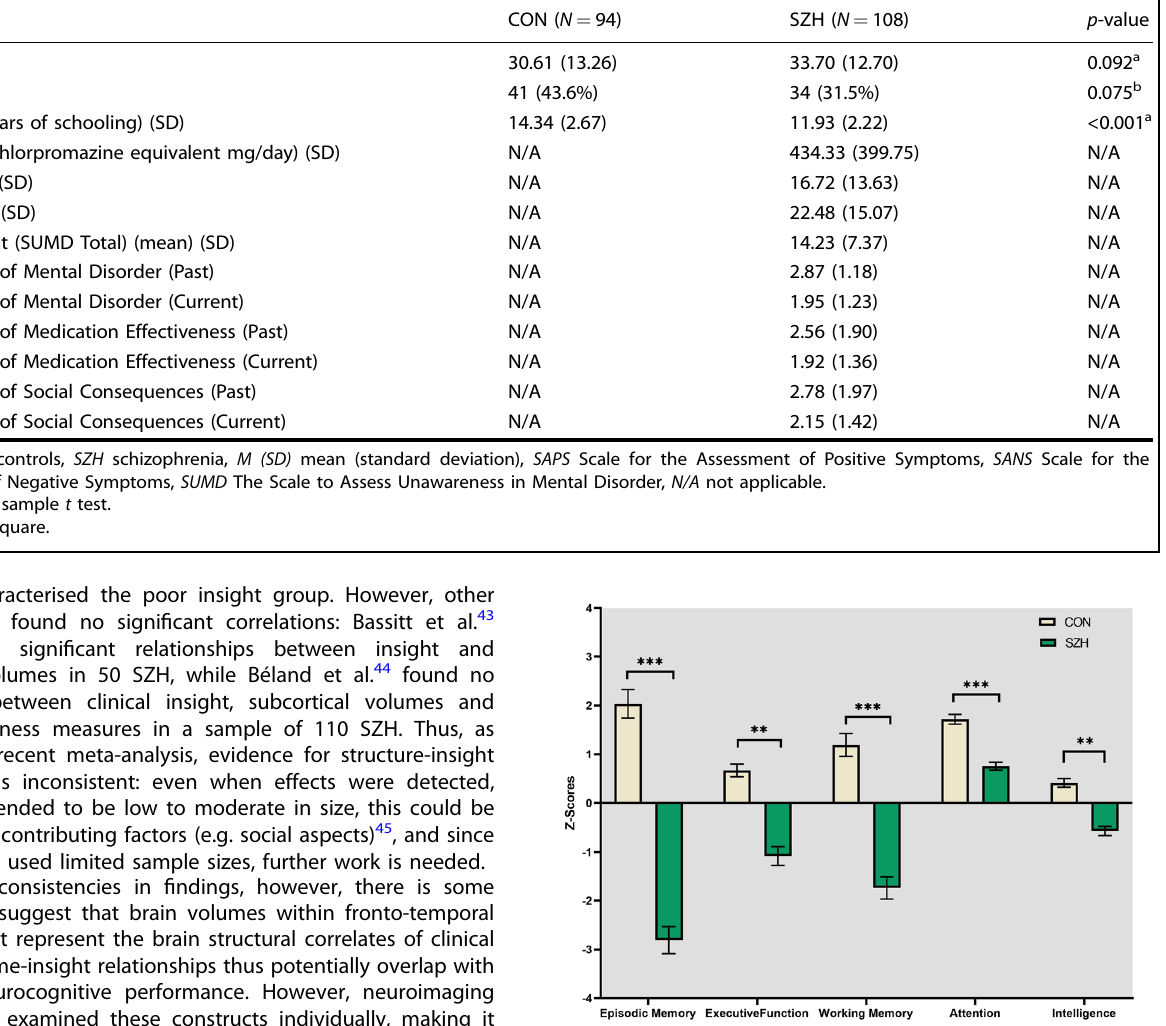
Fig. 1 Group Differences in Cognitive Scores between Controls (CON) and Schizophrenia Patients (SZH). *** p < 001, ** p <